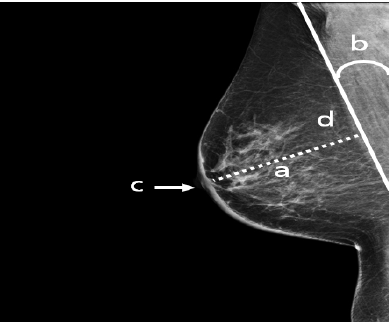
Figure 5. An adequate MLO view with (a) pectoralis to nipple level, (b) relaxed with an angle > 10°, (c) nipple in profile, and (d) visualized retroglandular fat.